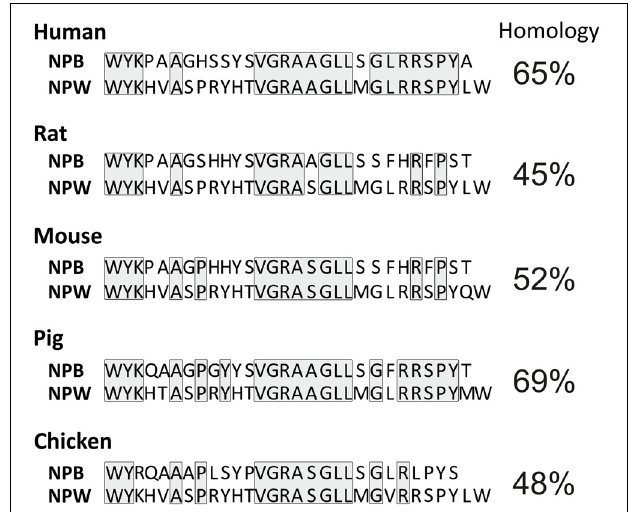
FIGURE 2 | Comparison of NPB and NPW peptides amino acid sequence in human, rat, mouse, pig, and chicken. Identical sequences of amino acid residues are